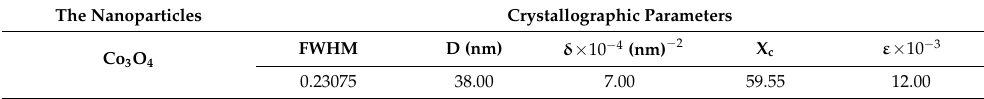
Table 1. The crystallographic parameters of Co 3 O 4